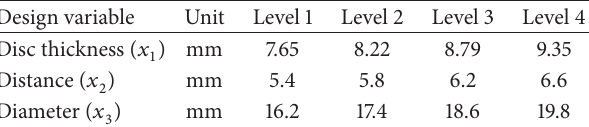
Table 2: Design variables and their